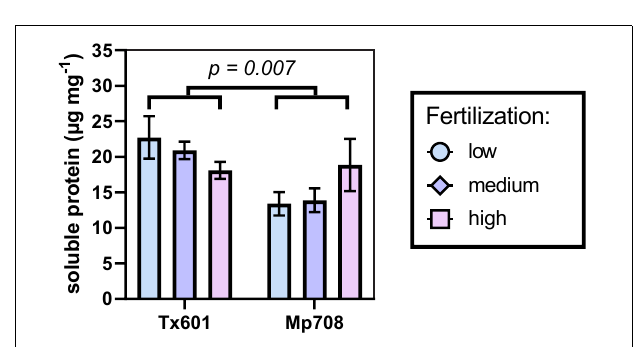
FIGURE 4 | Influence of fertilization treatment on soluble protein concentrations (fresh weight) in Tx601 and Mp708 foliage. Different concentrations of total proteins were observed between genotypes, but not within a fertilization